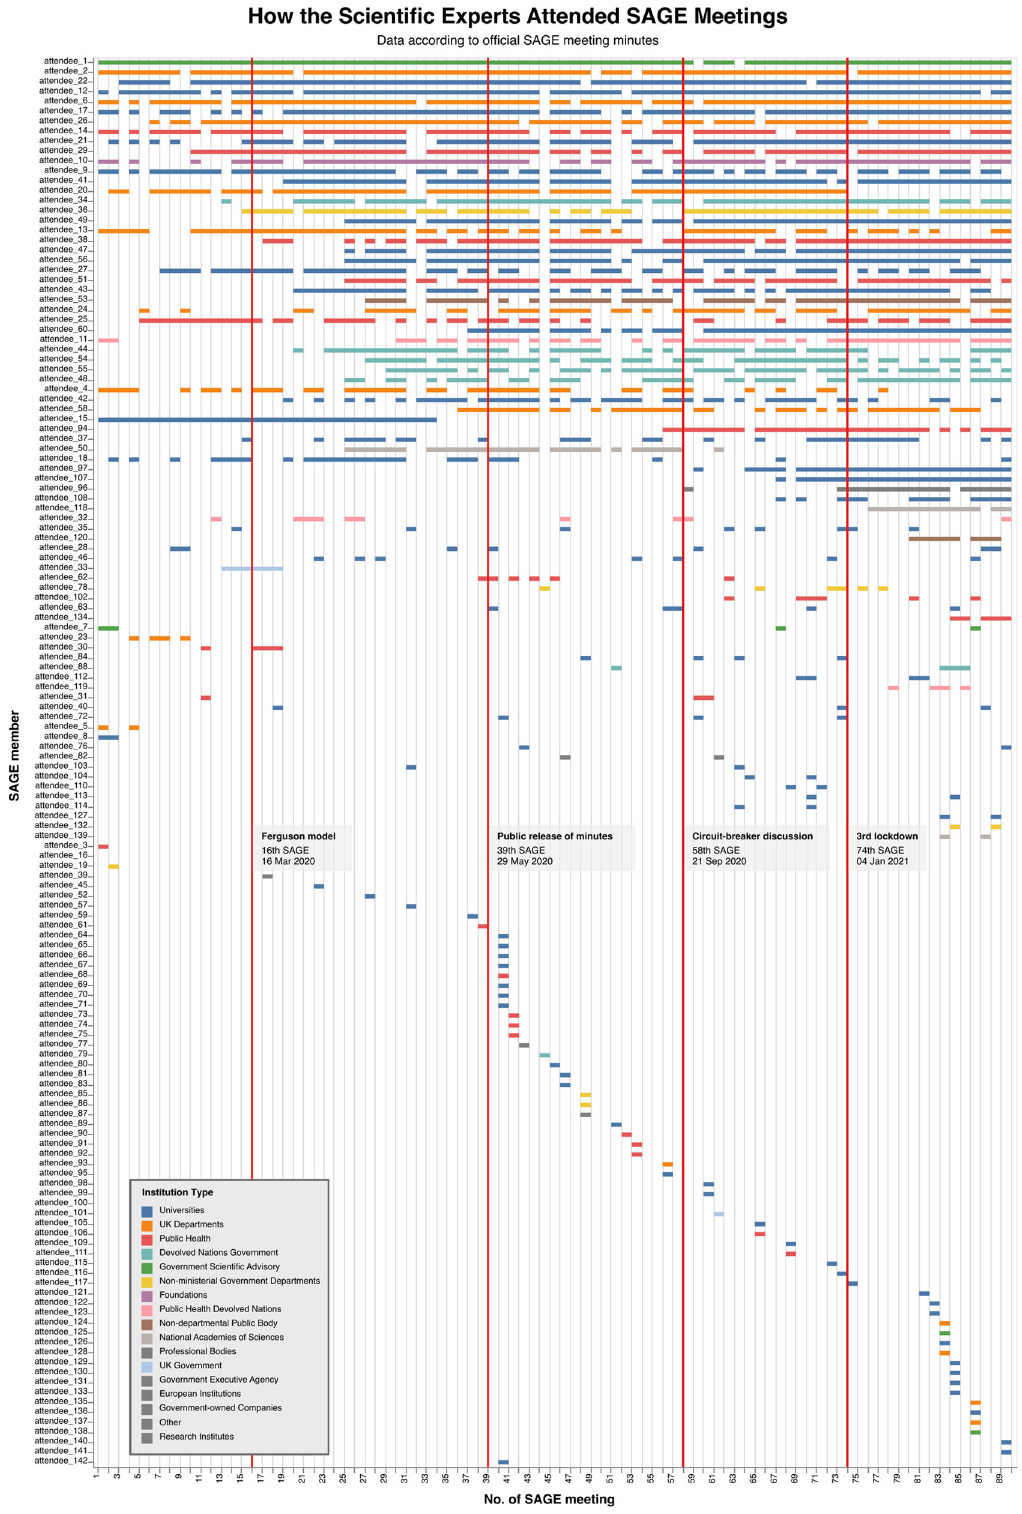
Fig. 3 Variation in SAGE experts ’ meeting attendance and institution type. Each row represents a different person we have classi fi ed as an expert, according to their most frequent role, and the meetings they attended. Institution types are indicated by colour and categorised by us based on information provided on SAGE ’ s list of participants. Original data source: SAGE Meeting Minutes (1 – 89) from UK Government (2021b).